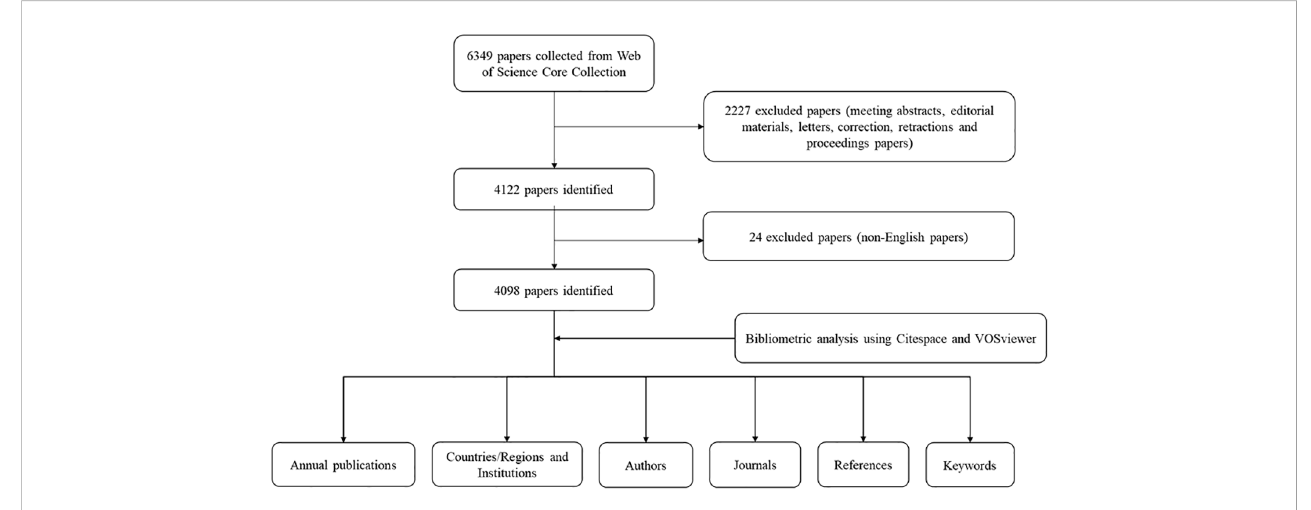
FIGURE 1 Flow chart of the data collection for research on beta-cell